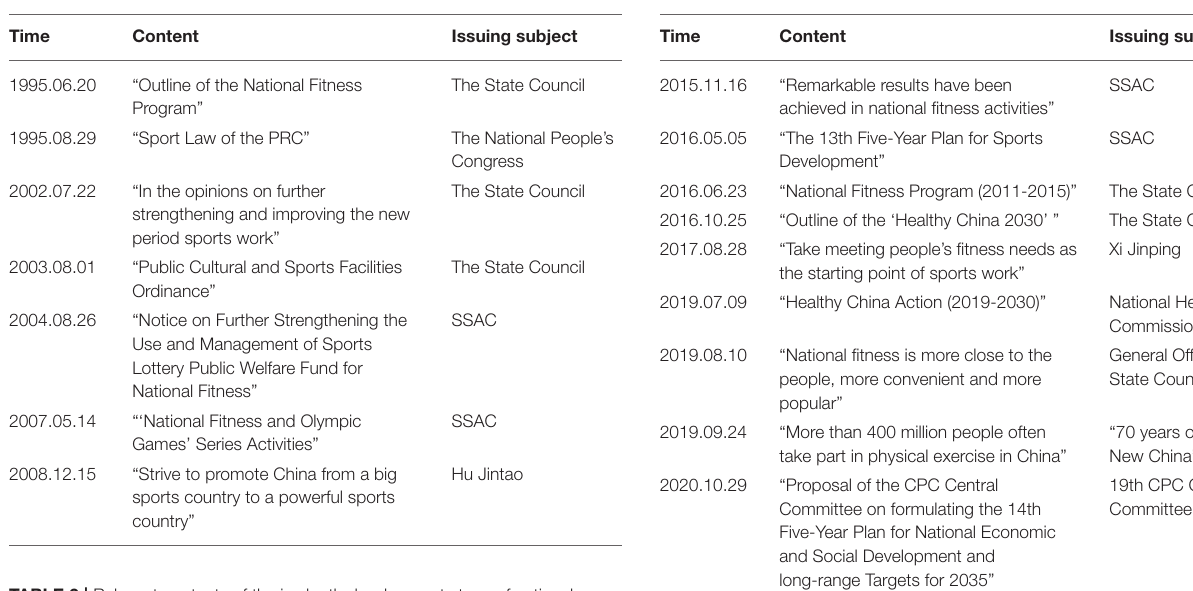
TABLE 3 | Relevant contents of national fitness optimization and upgrading